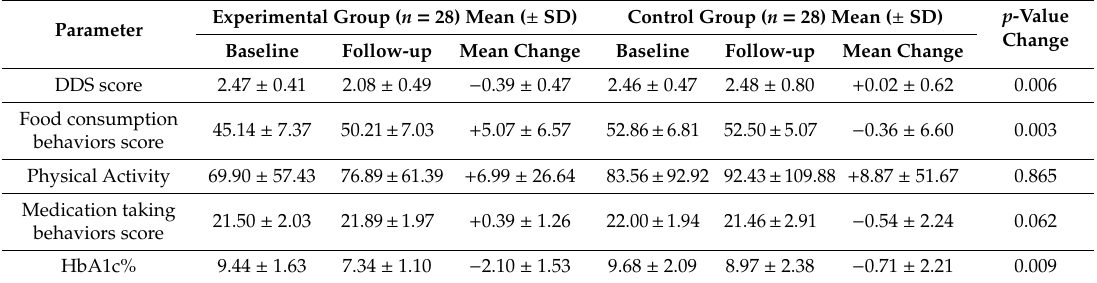
Table 3. Mean changes in outcomes from baseline to six-week follow-up (3 months for HbA1c levels).